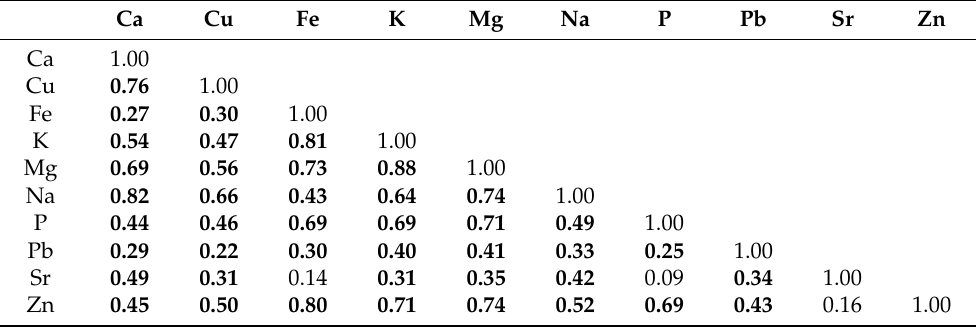
Table 4. Spearman’s rank correlation cofactors between elements in the maternal blood.